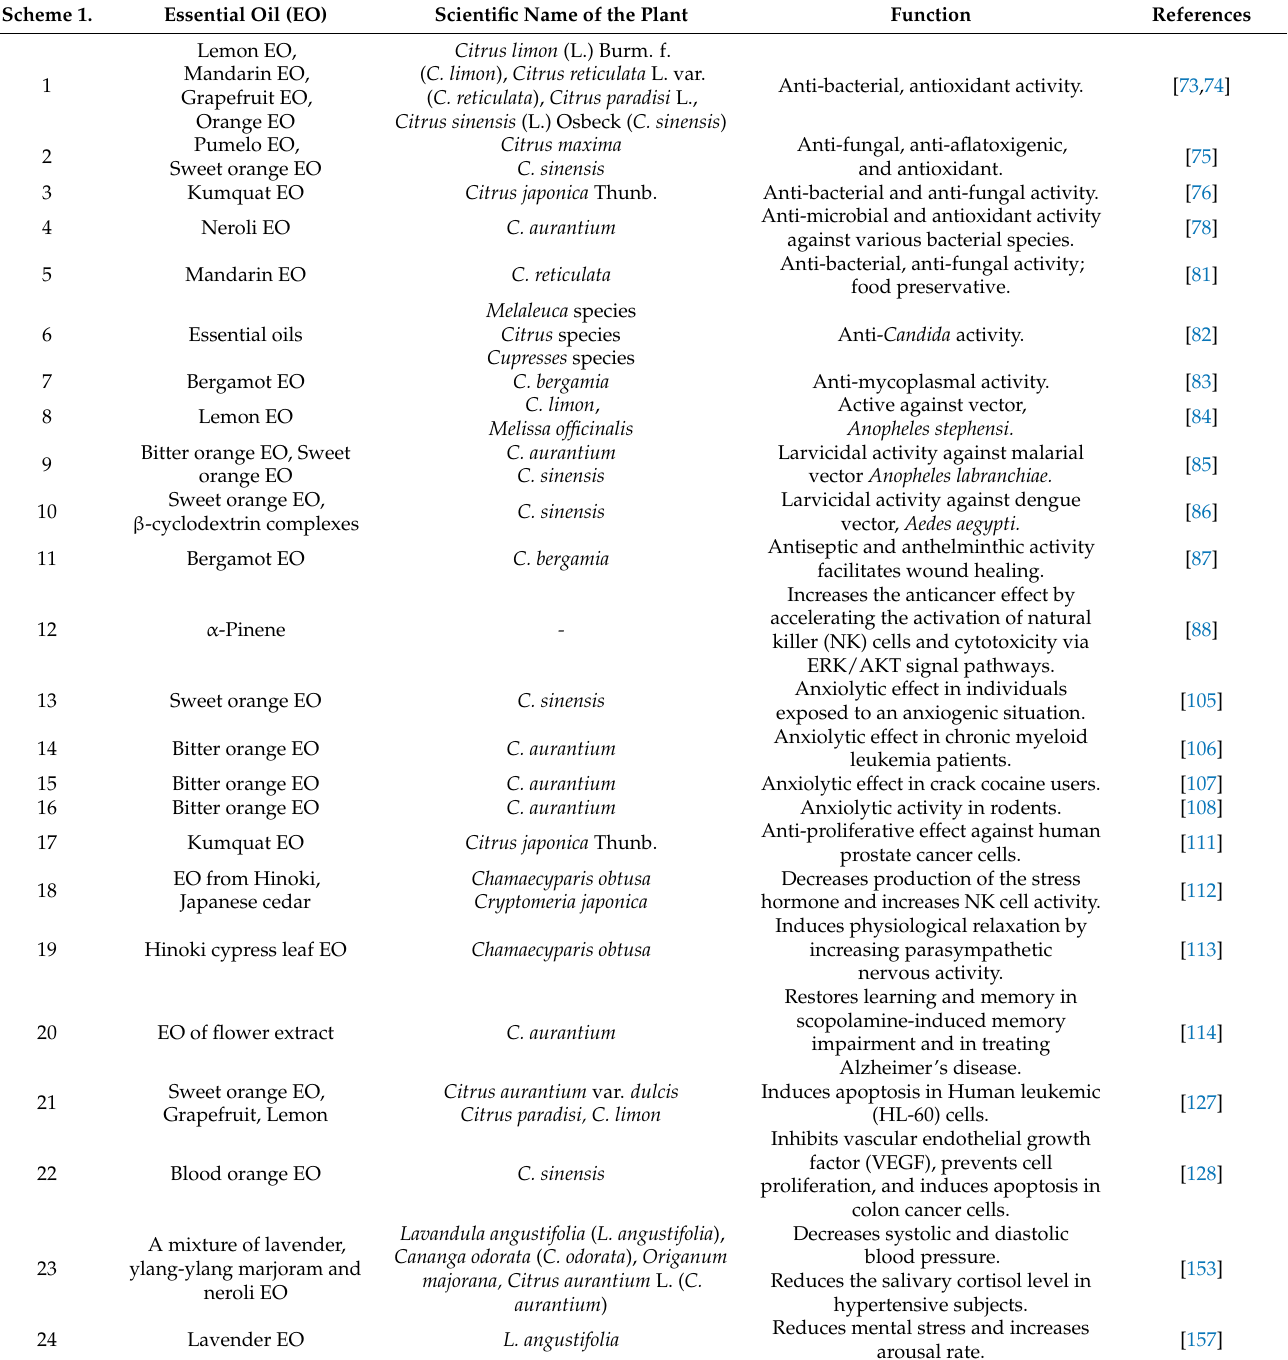
Table 2. The therapeutic effects of essential